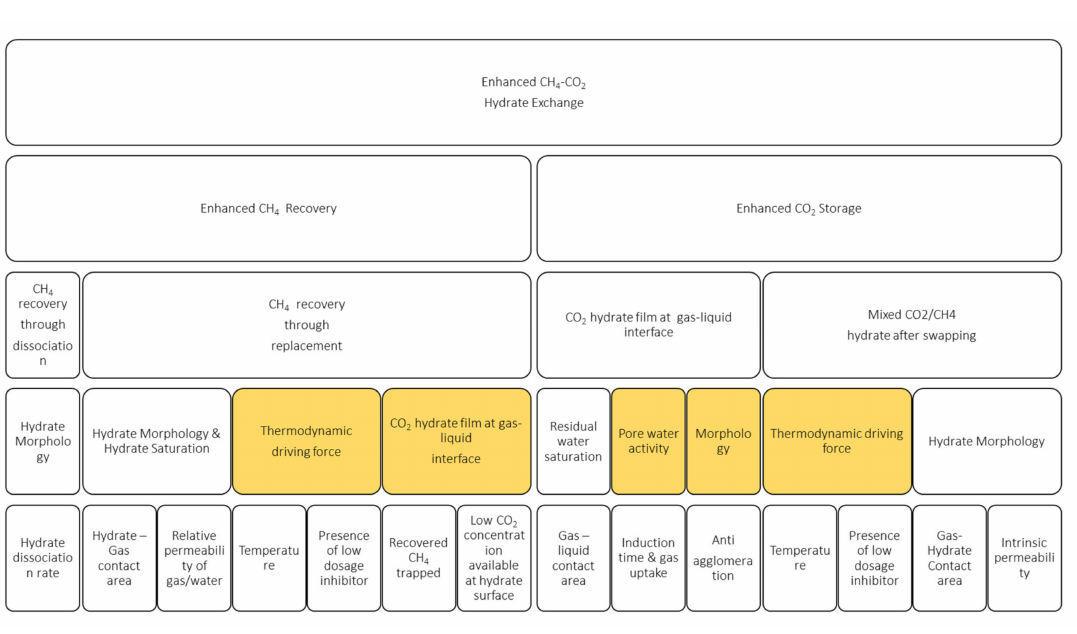
Figure 17. Flow chart illustrating di ff erent factors contributing to enhanced CH 4 -CO 2 exchange as discussed in the manuscript and influence of anti-agglomerate / inhibitor compounds in improving exchange and its impact on di ff erent factors (highlighted in